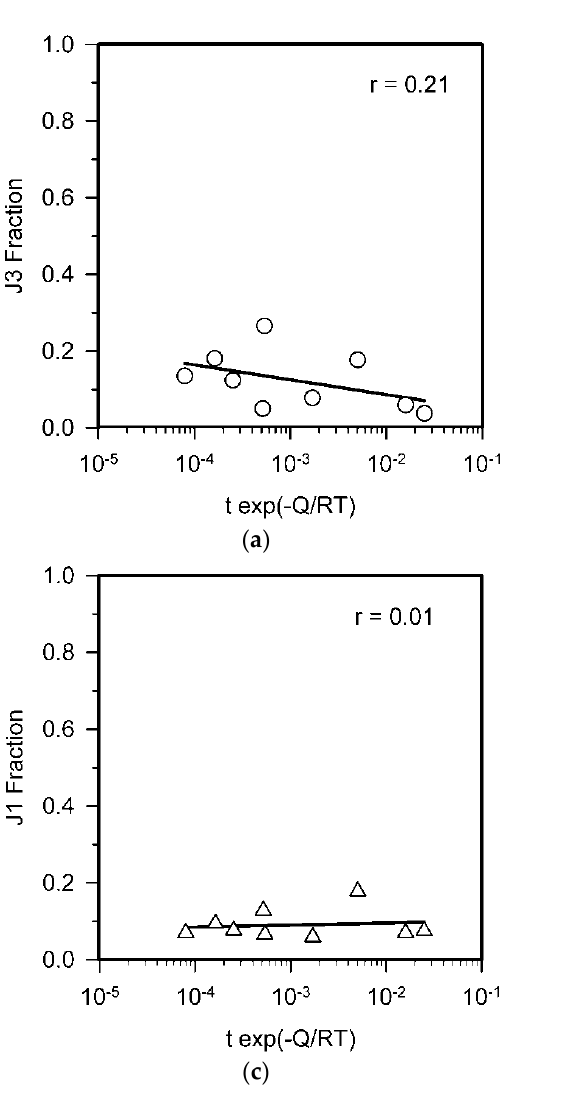
Figure 6. Effect of the temperature compensated annealing time on the fraction of triple junctions composed of three ordinary grain boundaries ( a ); two ordinary grain boundaries and one special boundary ( b ); one ordinary grain boundary and two special boundaries ( c ); and three special boundaries ( d ). The values of the determination coefficient (r) correspond to the linear regressions.